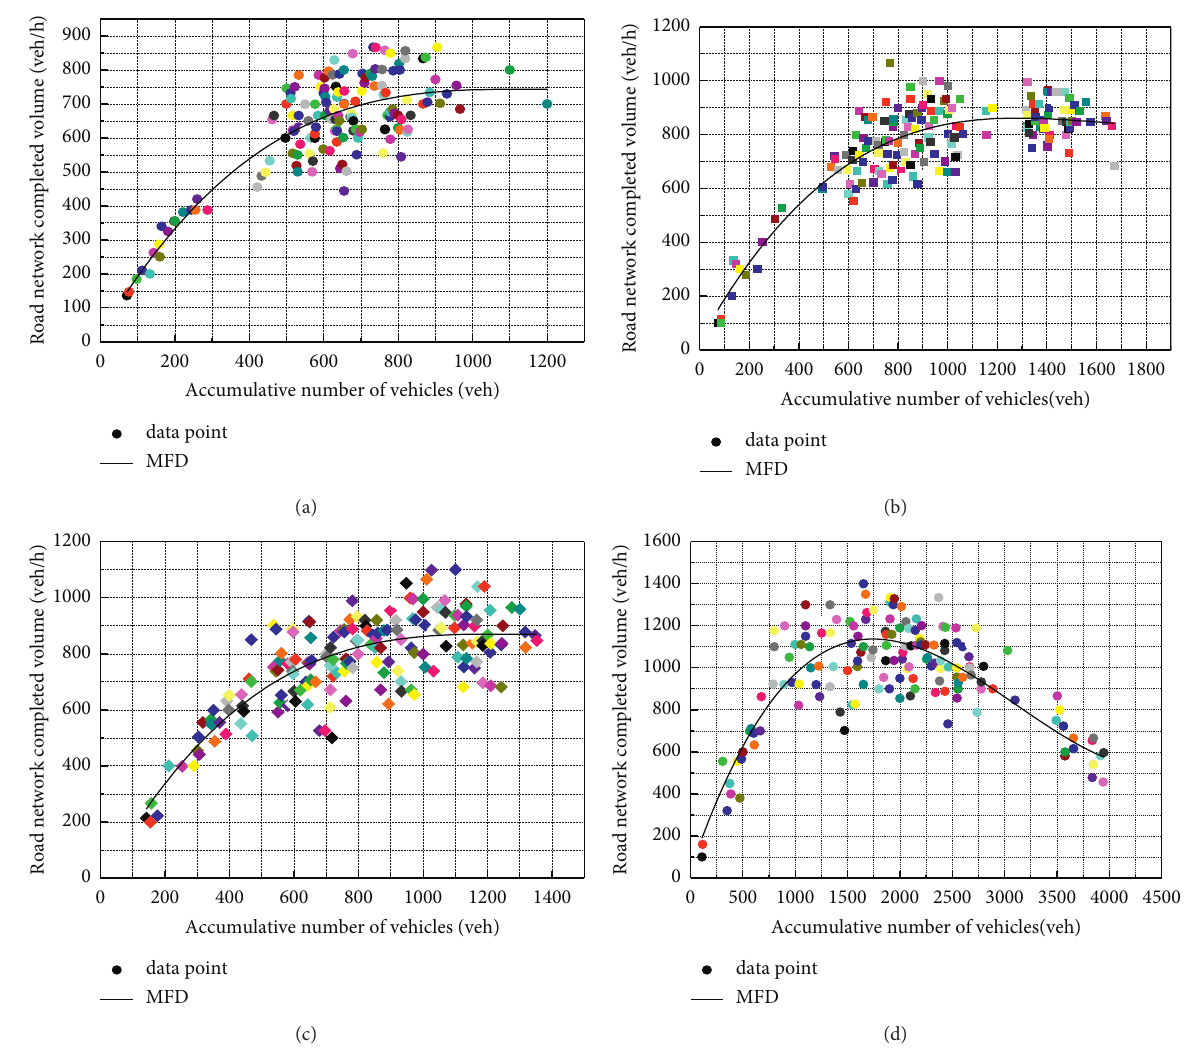
Figure 4: MFD of each subregion: (a) subregion 1; (b) subregion 2; (c) subregion 3; (d) subregion 4.